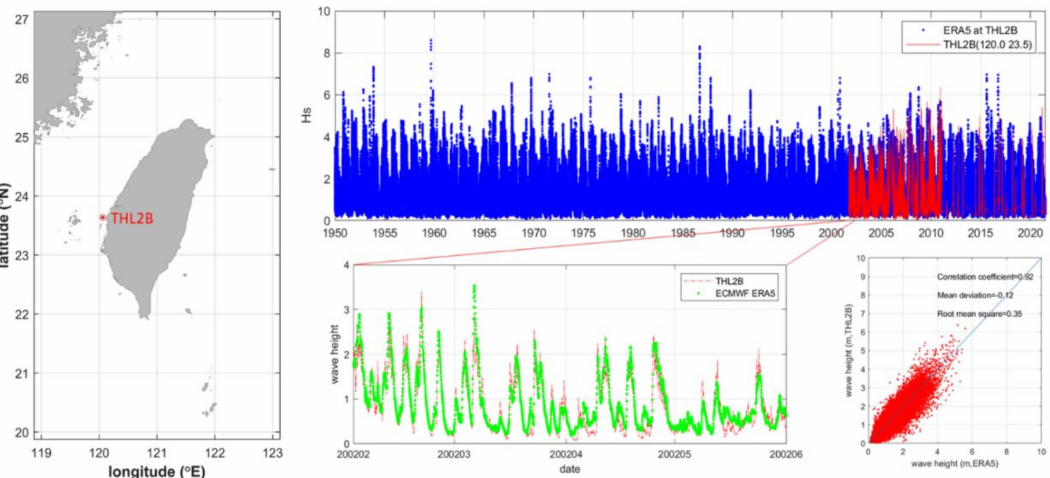
Figure 2. The location of THL2B site and correlation between the reanalysis data and the measured